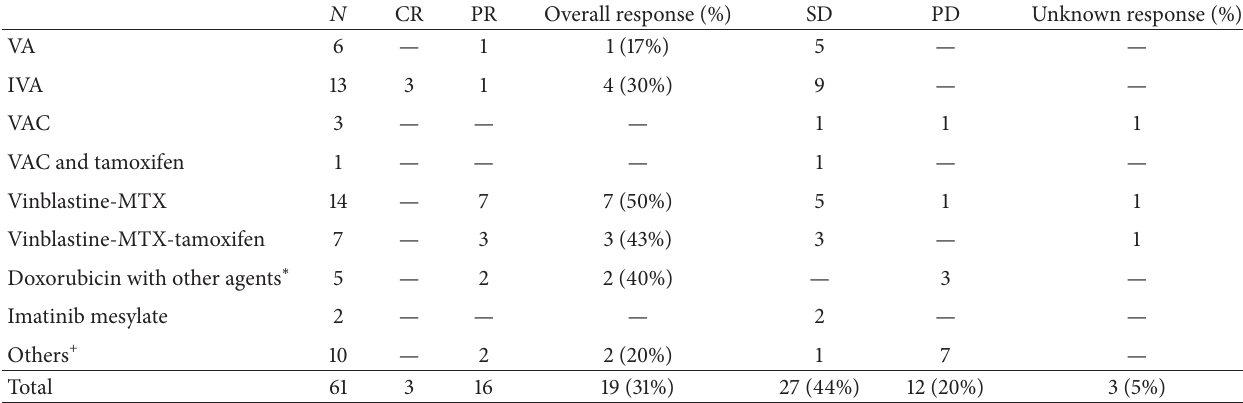
Table 3: Efficacy of 61 chemotherapy regimens in 32 patients with measurable disease during first or any subsequent line of therapy. 𝑁 CR PR Overall response (%) SD PD Unknown response (%)